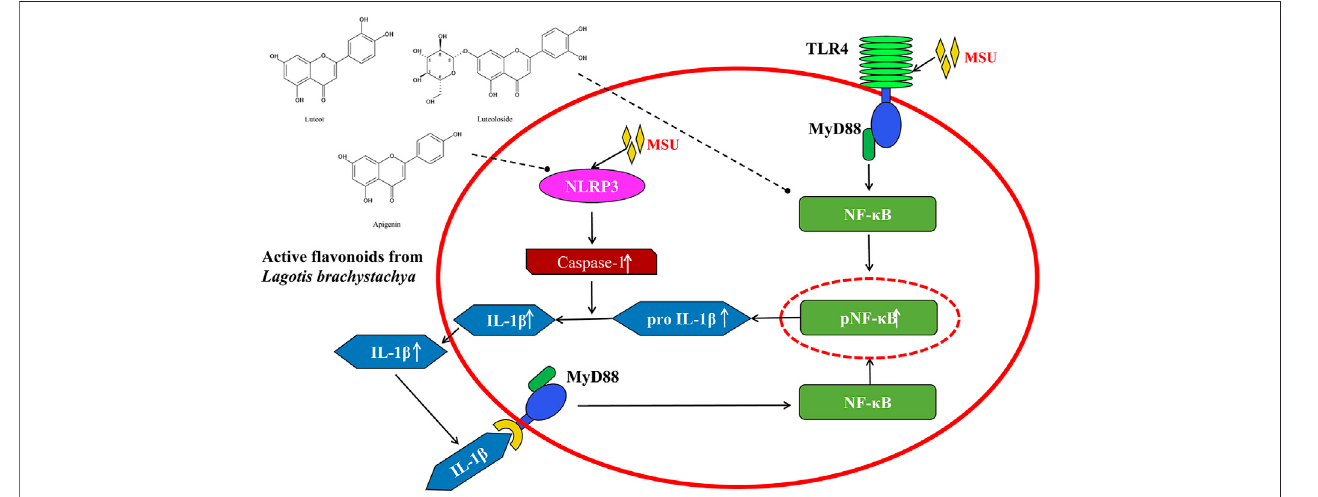
FIGURE 5 | The underlying mechanism involved in the protective effects of the active fl avonoids against gouty arthritis.